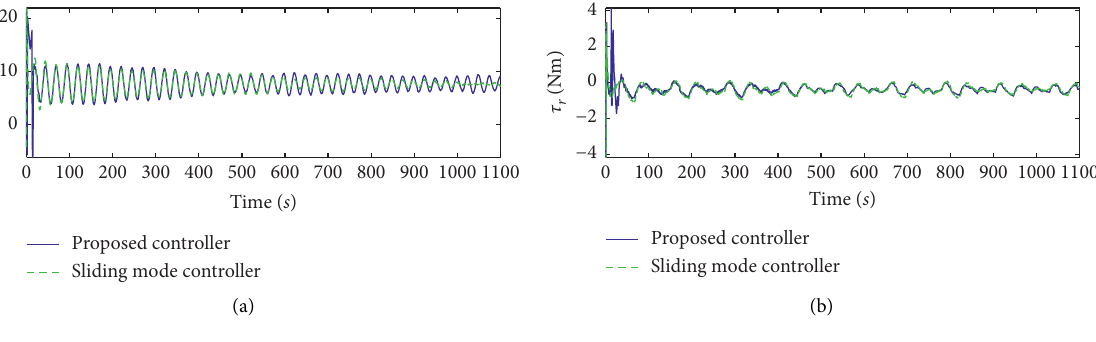
Figure 3: Position tracking errors.